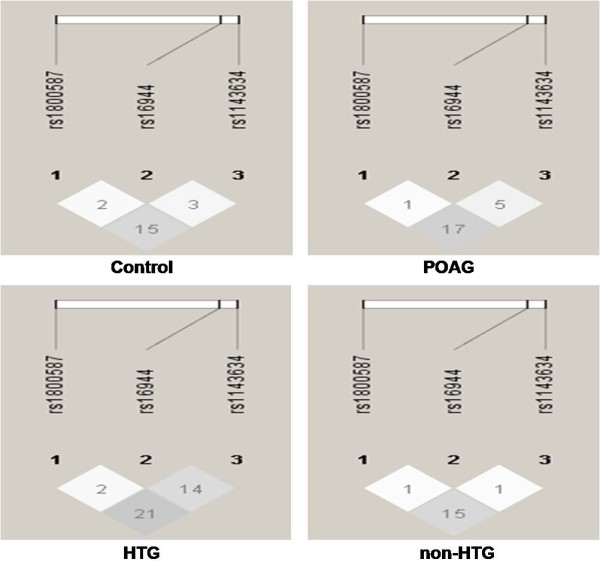
LD structure between the three SNPs in POAG patients and controls. No significant LD was observed between the three SNPs. The LD value was calculated using Haploview 4.1 software. The values in the boxes are the r-squared pairwise LD values given by the software. The standard r-squared color scheme is followed here i.e the extent of LD increases with darker shades.